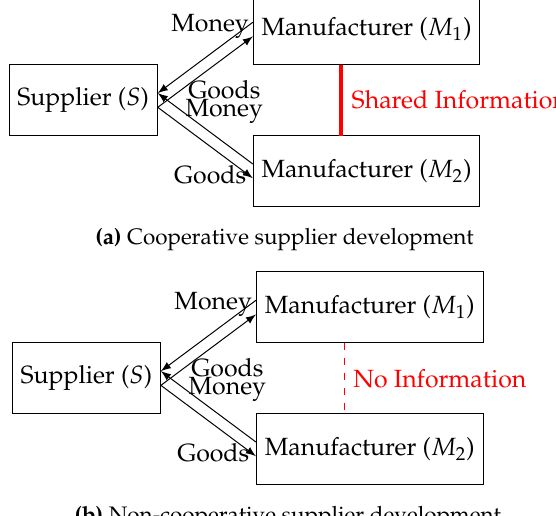
Figure 3. Cooperative ( a ) and Non-cooperative ( b ) supplier